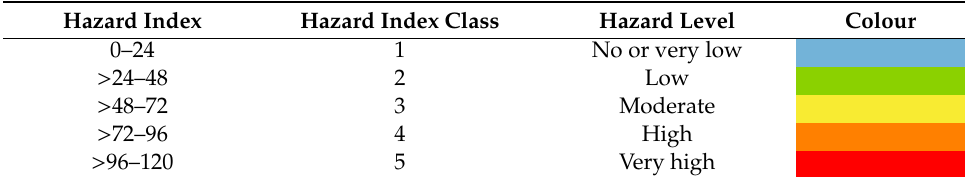
Table 4. Hazard index and hazard index